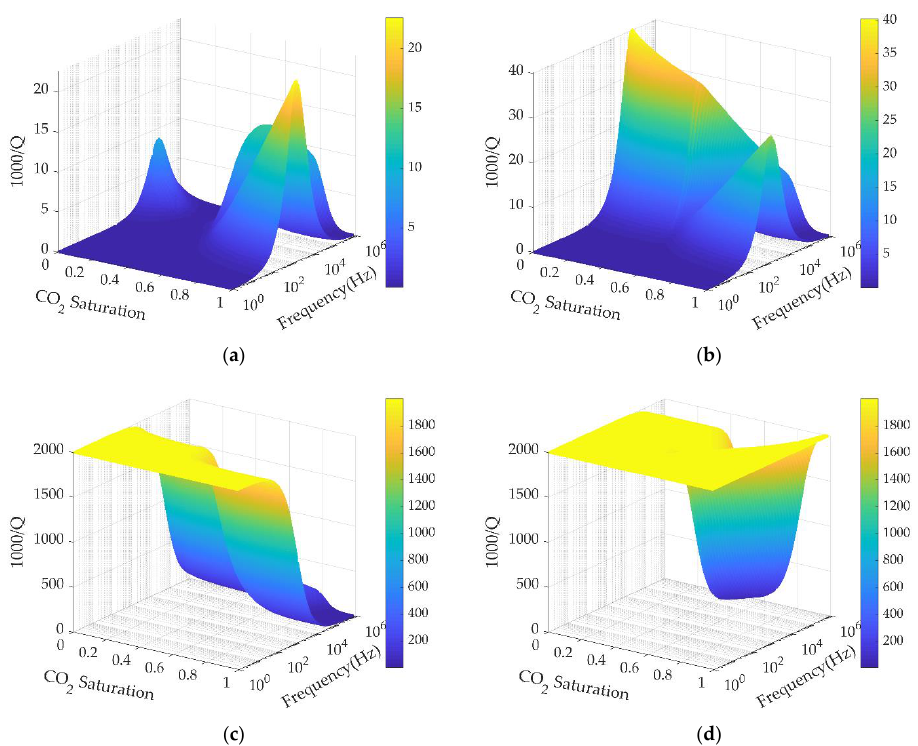
Figure 2. Effects of frequency and CO 2 saturation on the attenuations of four waves: ( a ) P1; ( b ) S1; ( c ) P2; ( d ) P3.